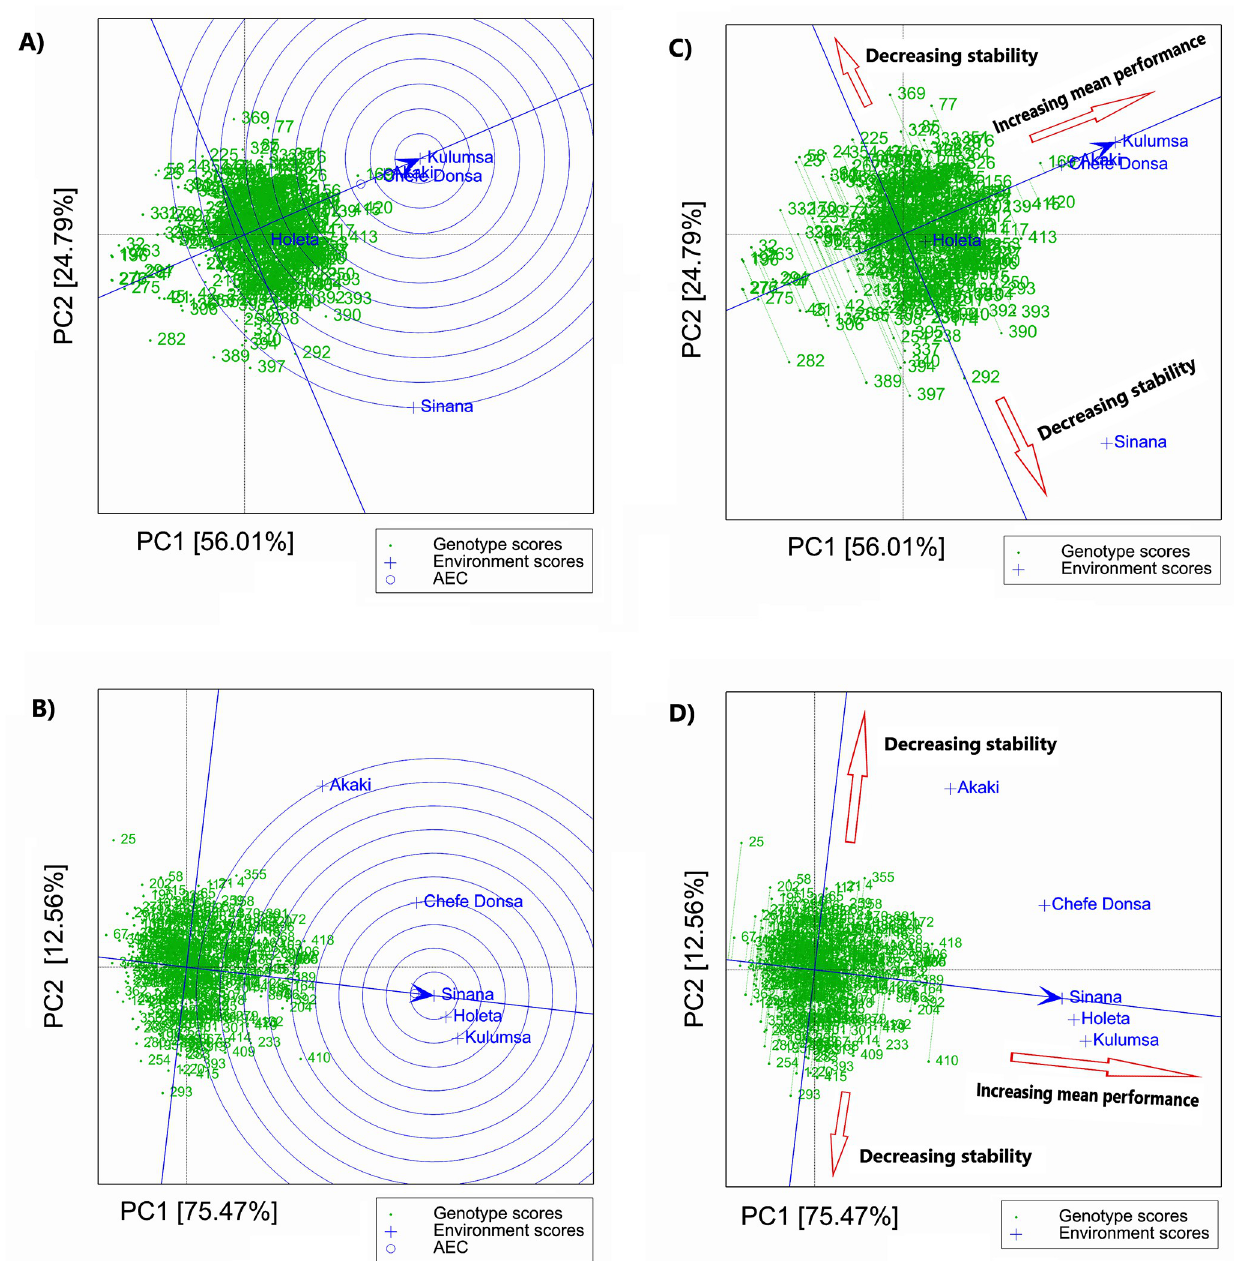
Fig 4. GGE-biplot showing the average environment coordination (AEC) based on the environment-focused scaling for grain yield (A) and thousand kernel weight (B), and the mean performance and stability of genotypes for grain yield at Kulumsa (C) and for thousand kernel weight at Sinana (D).